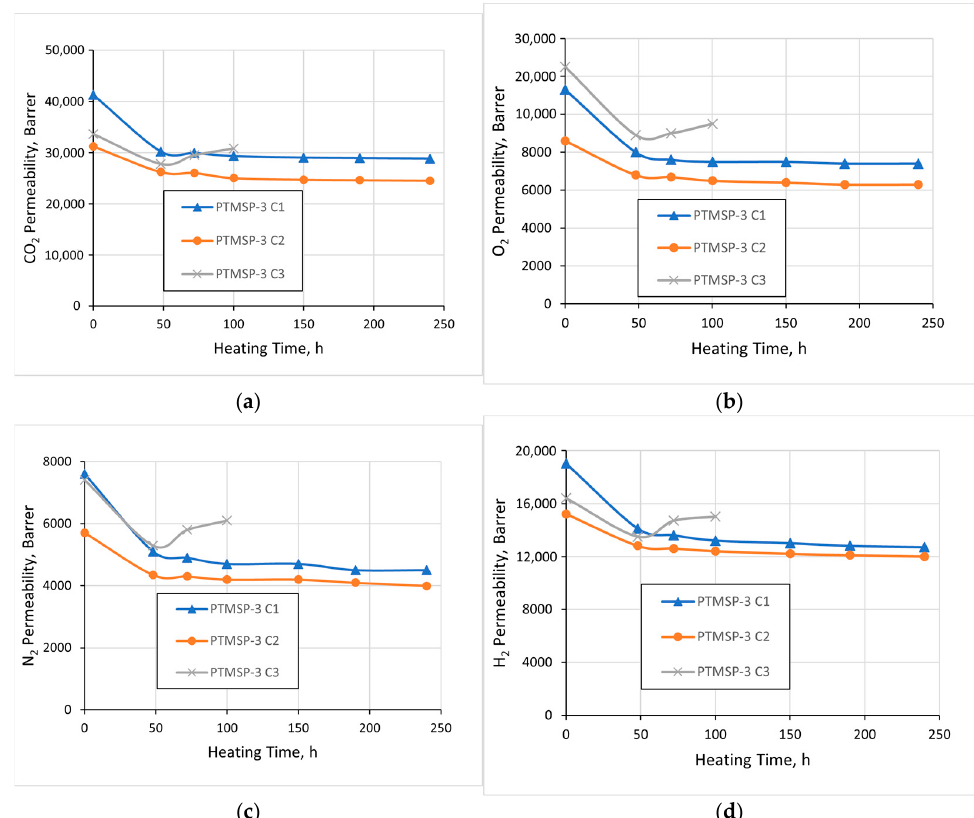
Figure 5. Gas permeability coefficients vs. heating time for the films of PTMSP-3 containing Irganox 1010 ( С 1), Vulkanox BKF ( С 2), and Vulkanox BHT ( С 3). ( a ) СО 2 ; ( b ) О 2 ; ( c ) N 2 ; ( d ) H 2 .